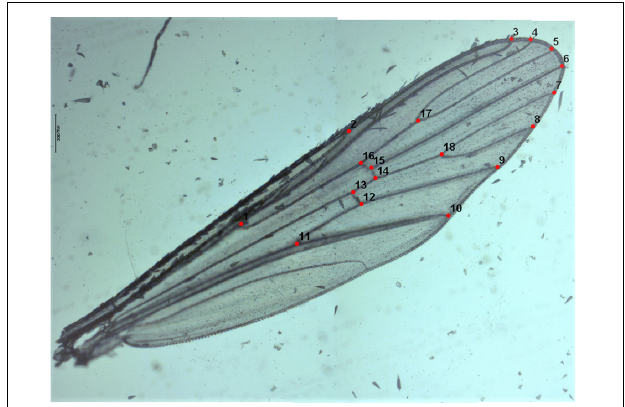
FIGURE 2 | Left wing of Ae. albopictus (female) mounted between a microscope slide and coverslip showing the 18 landmarks selected for the geometric morphometrics